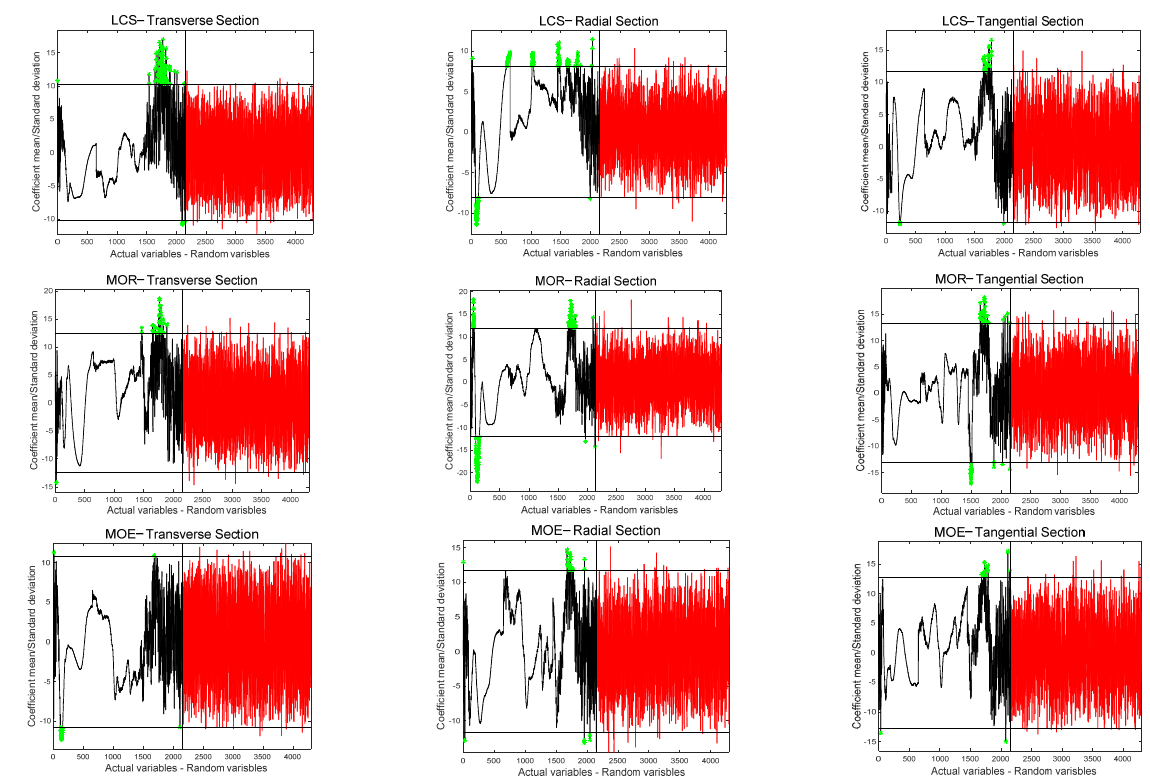
with different sections of MOR, only the radial section model had higher accuracy than the corresponding full-band spectral model. SPA obtained 10 characteristic wavelengths; the R 2 of calibration set and validation set were 0.4787 and 0.7635, and RMSE were 9.2175 and 5.2613, respectively. The accuracy of the SPA-PLS model in different sections of MOE was lower than the full-band spectral model, and the radial section SPA-PLS model was the best. SPA selects 10 characteristic wavelengths of radial section to construct PLSR model, with Rc 2 = 0.5598 and Rv 2 = 0.8394, RMSEc = 972.4311 and RMSEv = 575.7233.